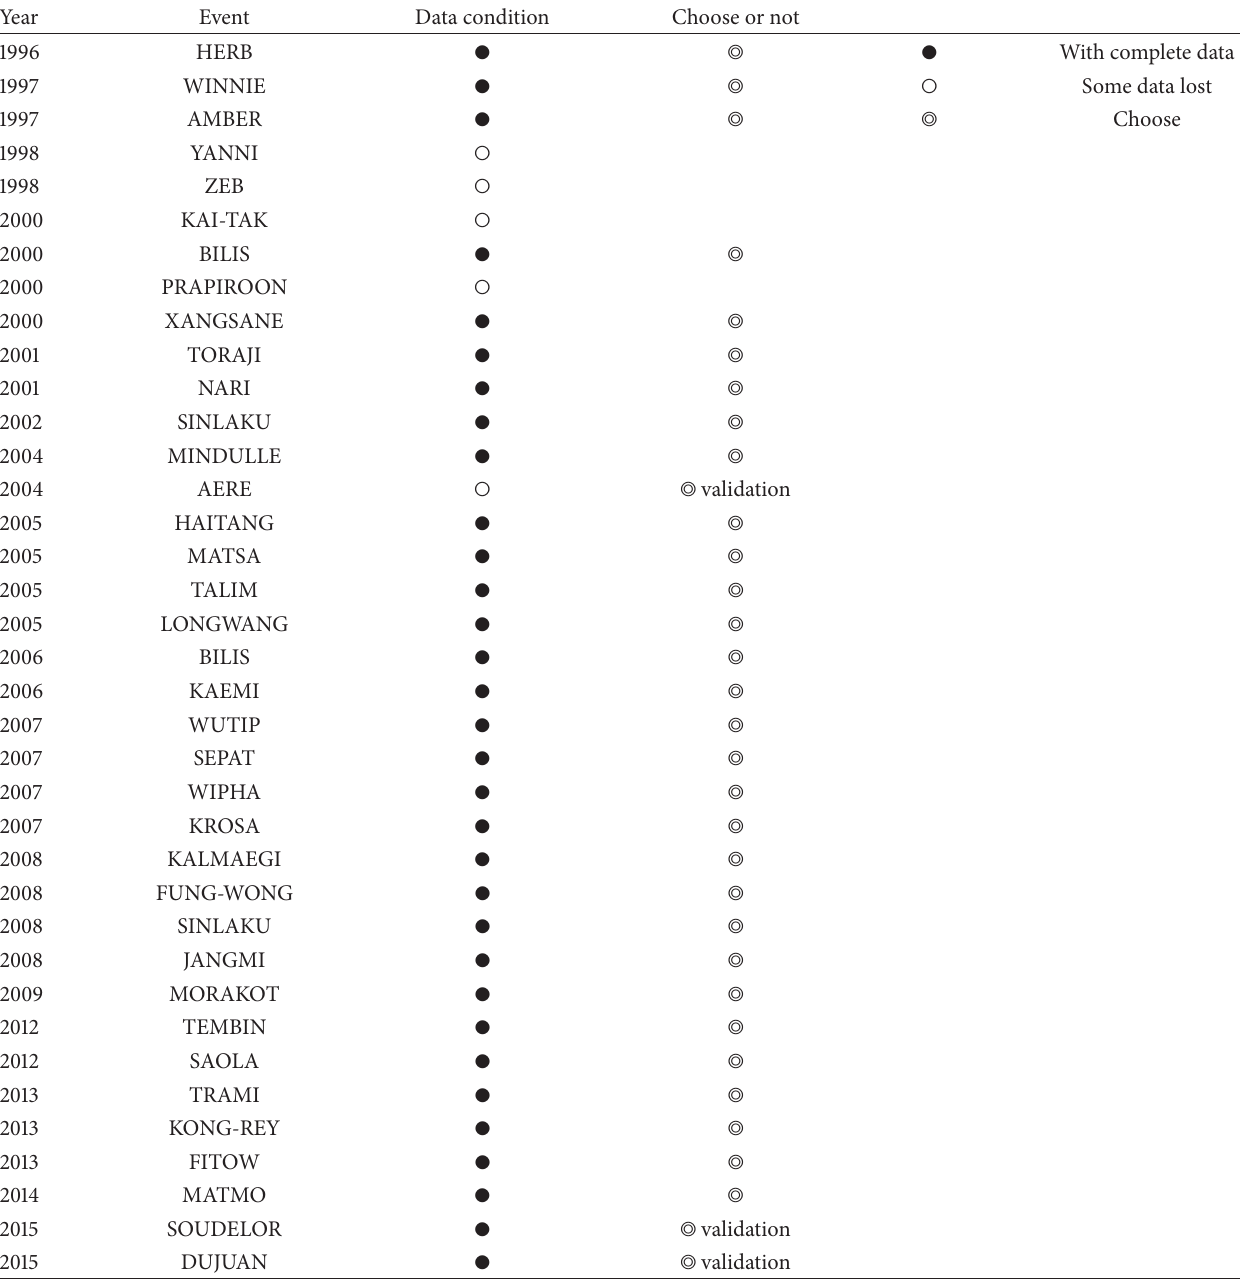
Table 1: The list of typhoon events collected in this study for the model